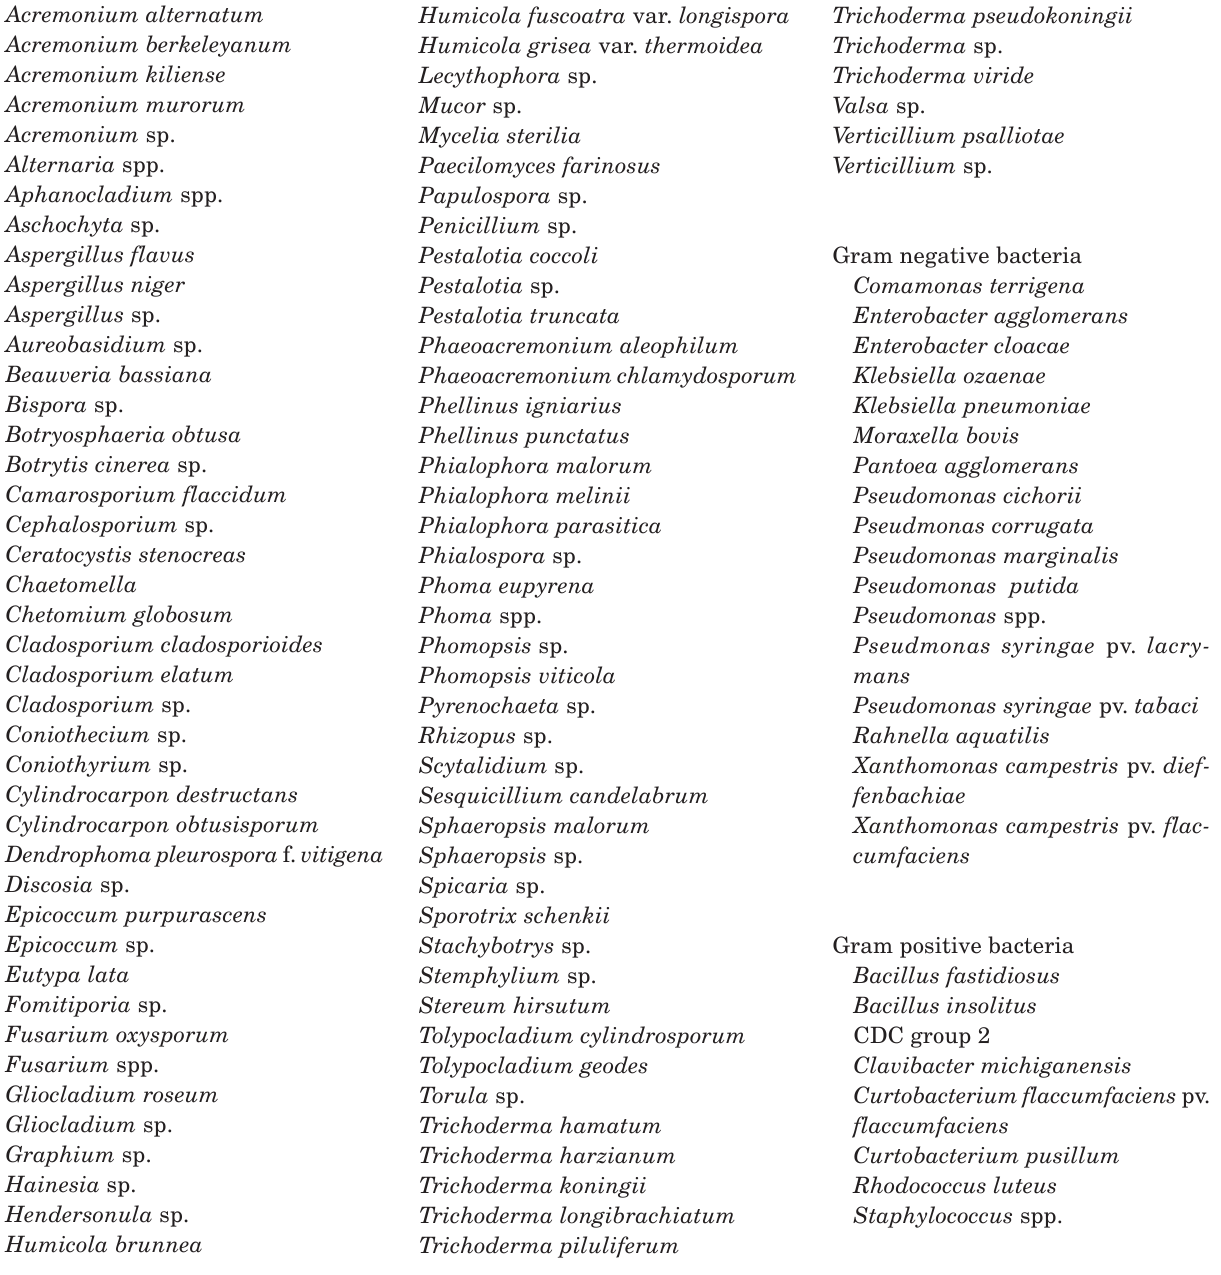
Table 3. Endophytic fungi and bacteria isolated from diseased and healthy grapevines by at least one of the follow- ing authors: Bell, 1985; Minervini and Bisiach, 1988; Contesini, 1996; Mugnai et al ., 1996; Esseln and Weltzien, 1997; Larignon and Dubos,